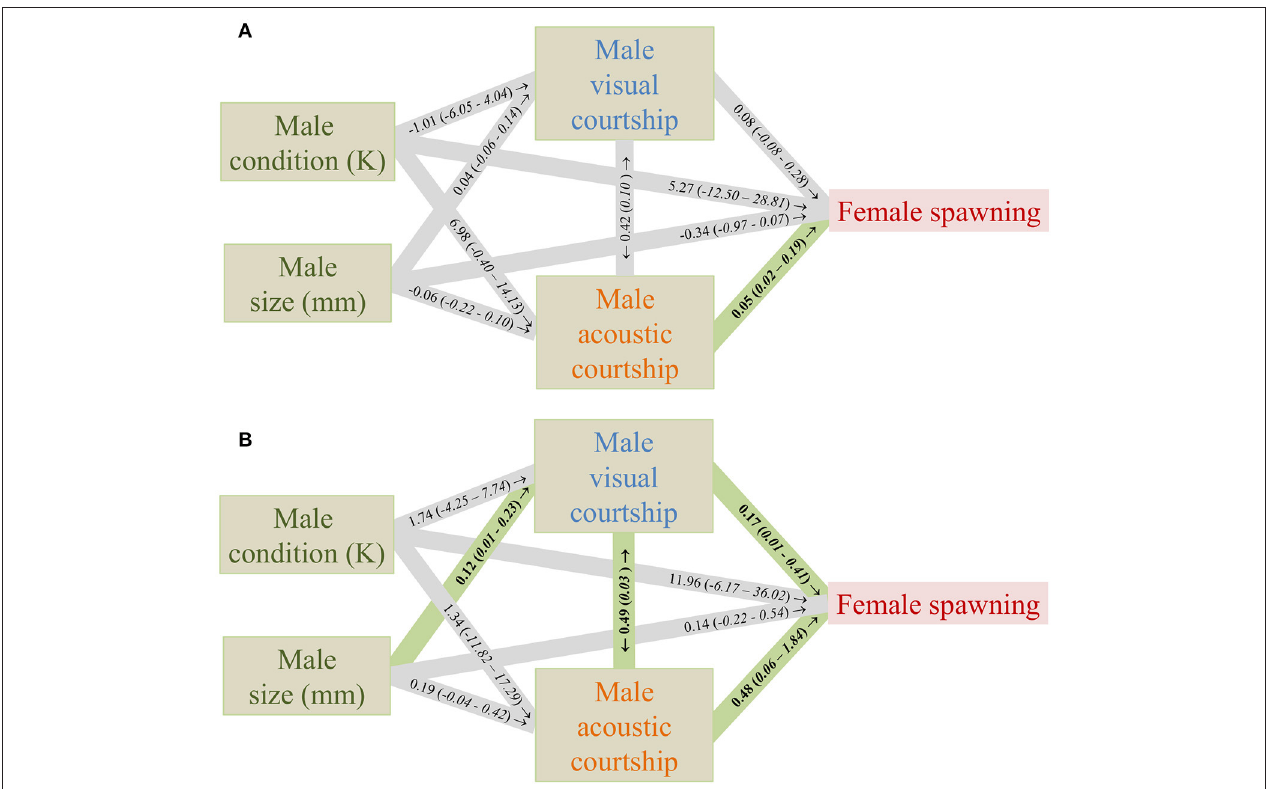
FIGURE 3 | Effects of measured variables on the likelihood of female spawning in an aquarium experiment in the Painted Goby in a control (A) and an added noise (B) treatment ( N = 16, 20). Numbers in the lines are effect sizes from generalized linear models with their confidence intervals between brackets. See Supplementary Files for full model reports. The correlation between acoustic and visual courtship was tested with a Spearman’s rank test, and therefore the rho is given with the P -value in brackets. Numbers in bold are significant effects ( P <